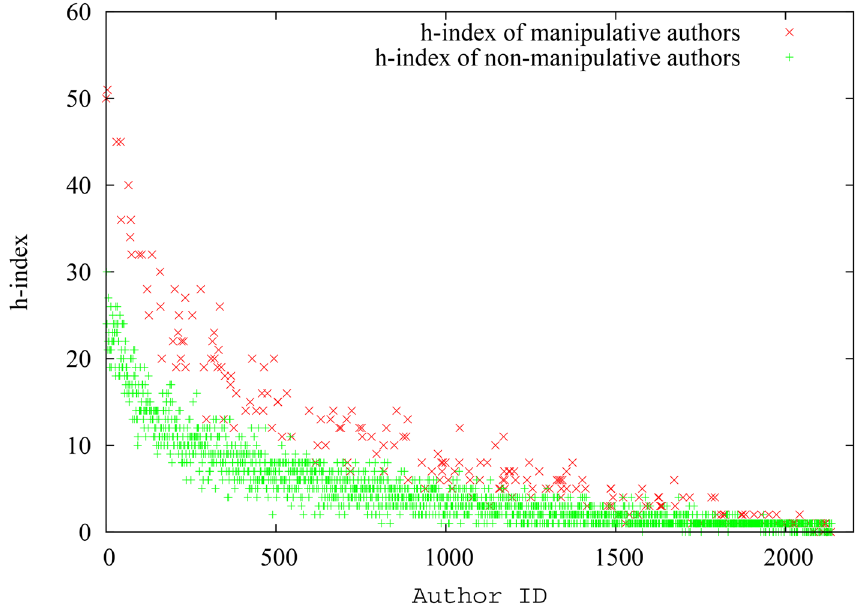
Fig 3. Spread of the h-index for each manipulative and non-manipulative author (as absolute values) in the first simulation scenario. For authors of similar seniority, the ‘ manipulative ’ author group has a clear